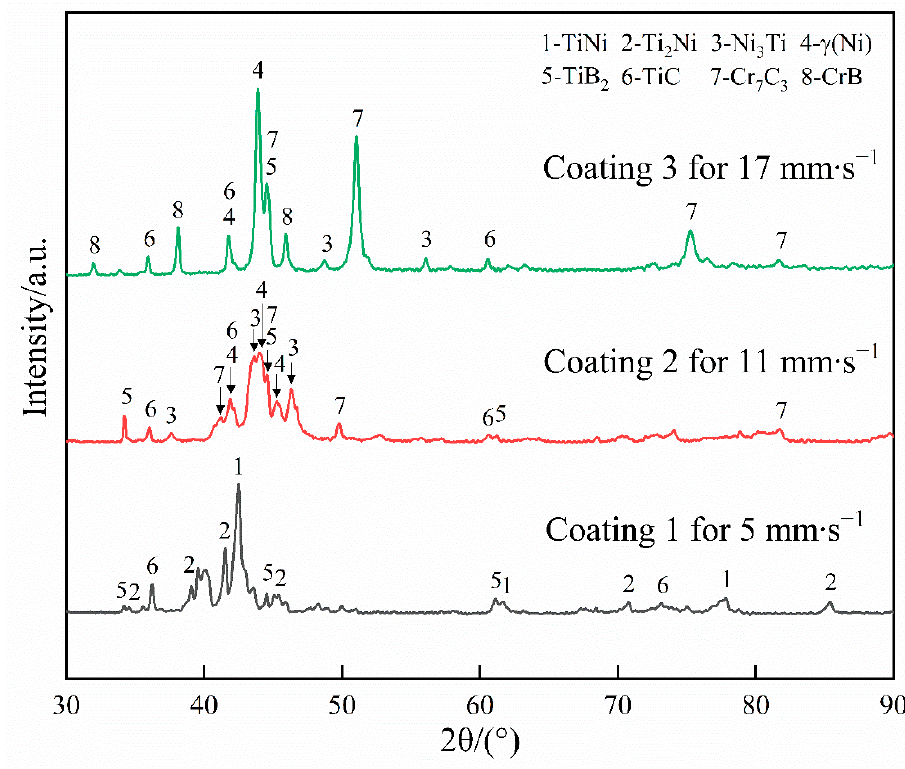
Figure 3. X ‐ ray diffraction patterns of the coatings. Table 1. The volume fractions of different phases in the coatings (vol.%).